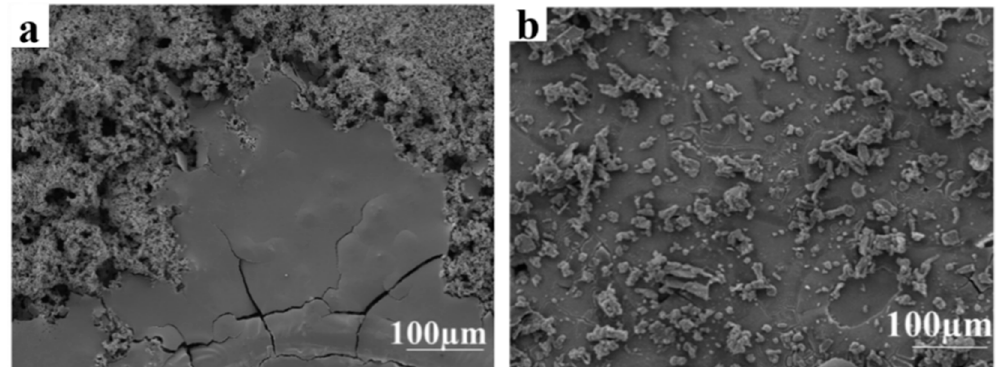
Figure 7. SEM morphology of S235 steel surface after five days of immersion in sodium chloride for the blank solution ( a ) and modified with ATP-6-AHA ( b ).